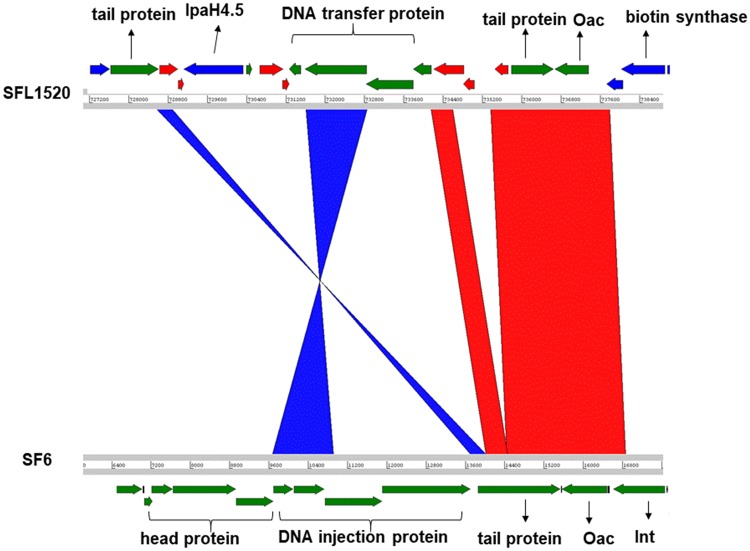
—Comparison of the oac gene region of SFL1520 (SHI-O PAI) and SF6 bacteriophage. The genomes are depicted as horizontal gray lines interspersed with regions of collinear (red) and inverted (blue) synteny. The direction of arrows indicates the open reading frames with color code: green, bacteriophage genes; red, IS elements/transposases; and blue, bacterial genes.